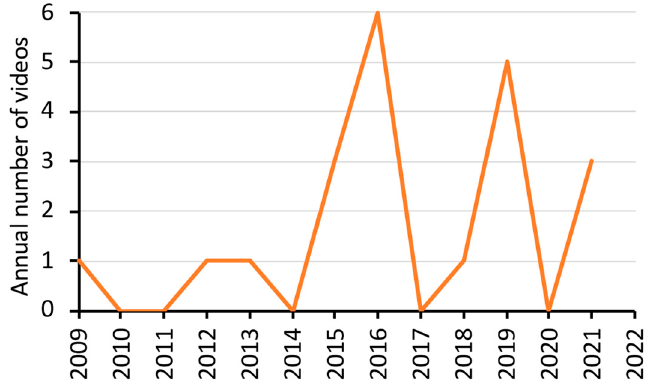
Figure 2. Number of YouTube videos uploaded each year that demonstrated periapical radiog- raphy.